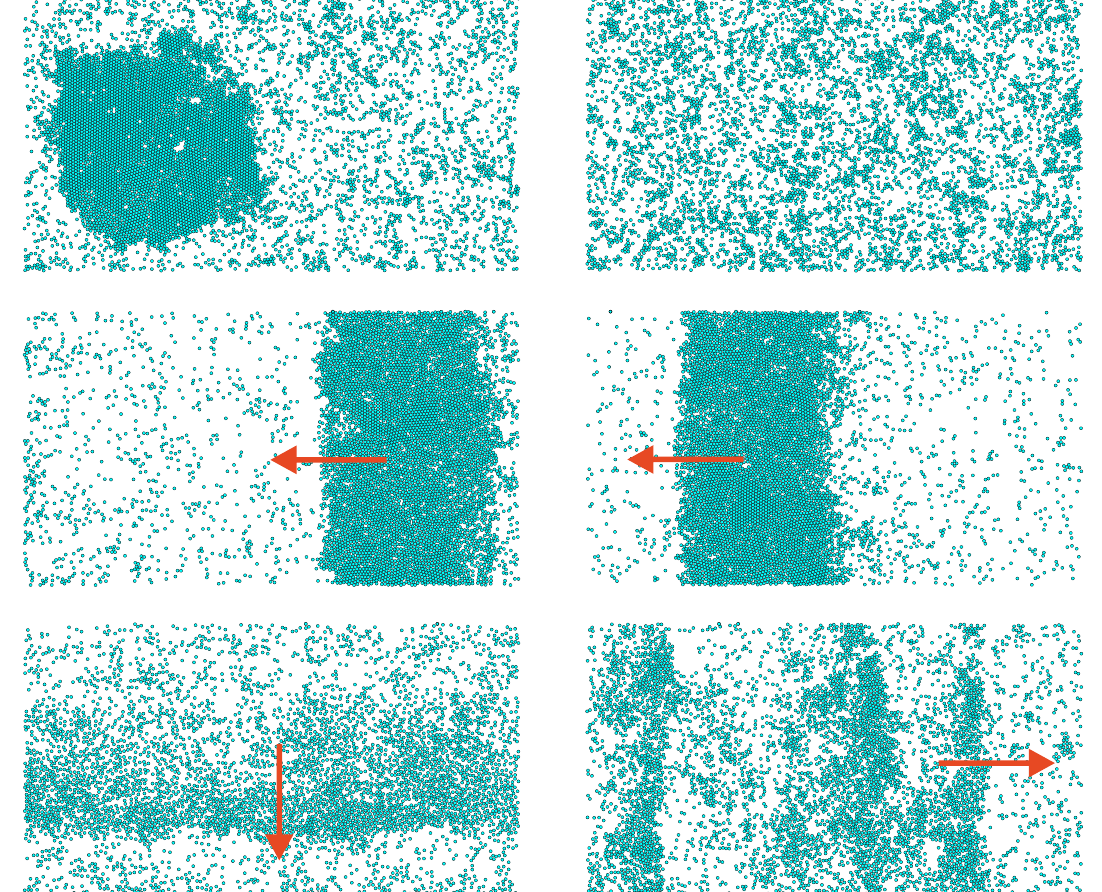
Figure 3. Simulation snapshots of typical states appearing in the system for different interaction strength T 0 and range R /σ as indicated by enlarged circles in the state diagram of Fig. 2. Top left panel: MIPS 0.1 and R /σ 2 1 / 6 ) and top right panel: dispersed state ( T 0 / k B T 1 and R /σ 2 1 / 6 ). Middle ( T 0 / k B T = = = = 10 and panel: Flocking (band). Two snapshots of a coherently moving band of active particles ( T 0 / k B T = 2 1 / 6 ) are shown, with a time of 3 D − 1 R /σ R in between them. Bottom panel: Flocking (dynamic). Left: = 100 and R /σ 1.15 ). Motion of a moderately dense and dynamically varying stripe of particles ( T 0 / k B T = = 30 and R /σ 2 1 / 6 ). Red arrows denote the Right: Motion of several dynamically varying stripes ( T 0 / k B T = = 0.24 and Pe 80 direction of coherent motion. In all cases (cid:31) = =